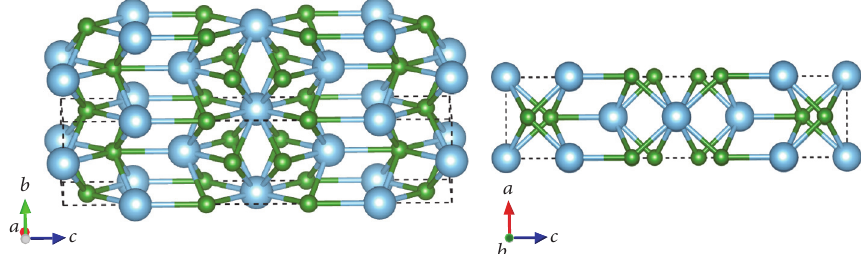
Figure 4: The 1 × 2 × 1 supercell of Ti 3 B 4 . Blue and green balls denote Ti and B atoms, respectively. Dashed box represents the unit cell of Ti 3 B 4 crystal.